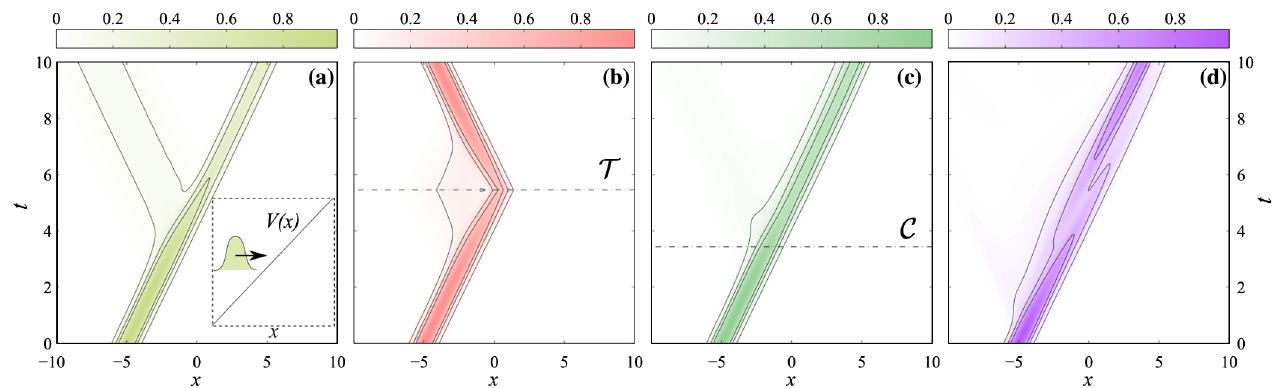
FIG. 2. Scattering of a fermion against a linearly growing potential (inset). (a) Ordinary Klein process. (b) At an instant of time indicated by the dashed line we apply the time-reversal operator T causing the particle to retrace its own trajectory. (c) Similar to (b) but now we apply charge conjugation, converting the particle into its antiparticle. (d) Scattering of a Majorana particle, which propagates through the potential. Parameters are m ¼ 0 : 5 , c ¼ 1 , and V ð x Þ ¼ x , in dimensionless